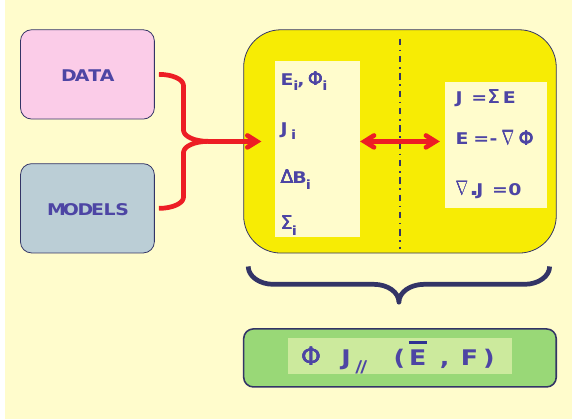
Fig. 3. Synopsis of the AMIE procedure. The outputs for the sim- ulation are the convection potential φ , the field-aligned current J // and the electron precipitation mean energy ¯ E and energy flux F